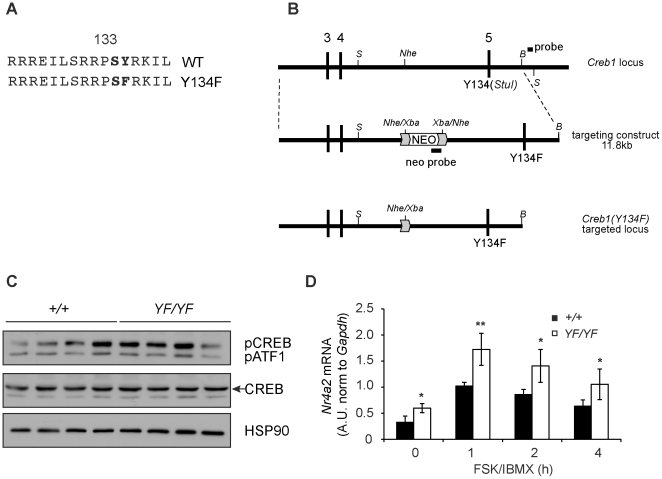
CREB-YF enhances myoblast response to cAMP.A) Amino acid sequence of CREB PKA phosphorylation site (Ser133) showing Y134F mutation. B) Targeting strategy for CREB-YF knock-in strain. Mouse Creb1 locus with Y134 in exon 5 (top); targeting construct inserts neo cassette in intron 4 and Y134F/StuI mutation (middle); targeted locus contains Y134F mutation. S, B: StuI, BamHI restriction sites. Southern probes indicated. C) Phospho-CREB, CREB and HSP90 protein in gastrocnemius muscle from Creb+/+ and CrebYF/YF mice. n = 4 per genotype. D) Nr4a2 mRNA in primary skeletal myoblasts from wild-type and CREB-YF mice, stimulated with FSK/IBMX for indicated times. Nr4a2 normalized to Gapdh, expressed in arbitrary units (A.U.). **, p<.01; *, p<.05 between genotypes. Average of 3 experiments ± stdev.